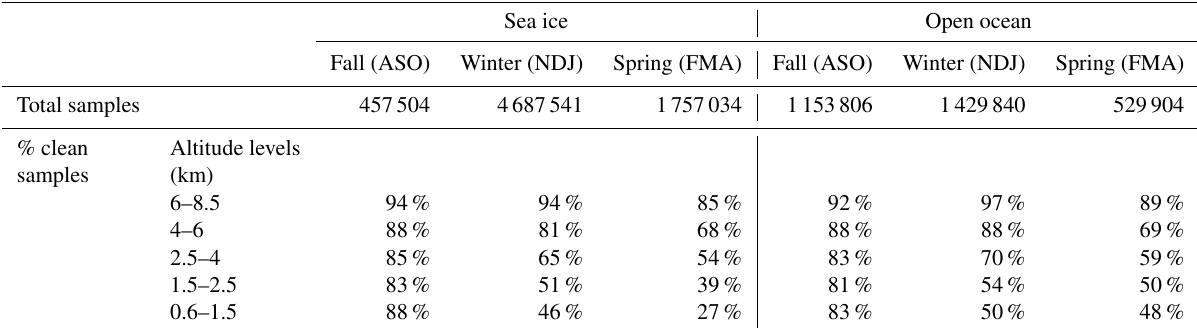
Table 2. Total profile numbers during each season of the study over sea ice and open ocean regions. Also shown are the percent of samples determined to be clean (BC<30ngm − 3 ) at different altitudes. Seasonal differences in sample numbers depend on factors such as solar illumination; sea ice extent; and, for clean samples, seasonal variations in BC levels. Sea ice Open ocean Fall (ASO) Winter (NDJ) Spring (FMA) Fall (ASO) Winter (NDJ) Spring (FMA) Total samples 457504